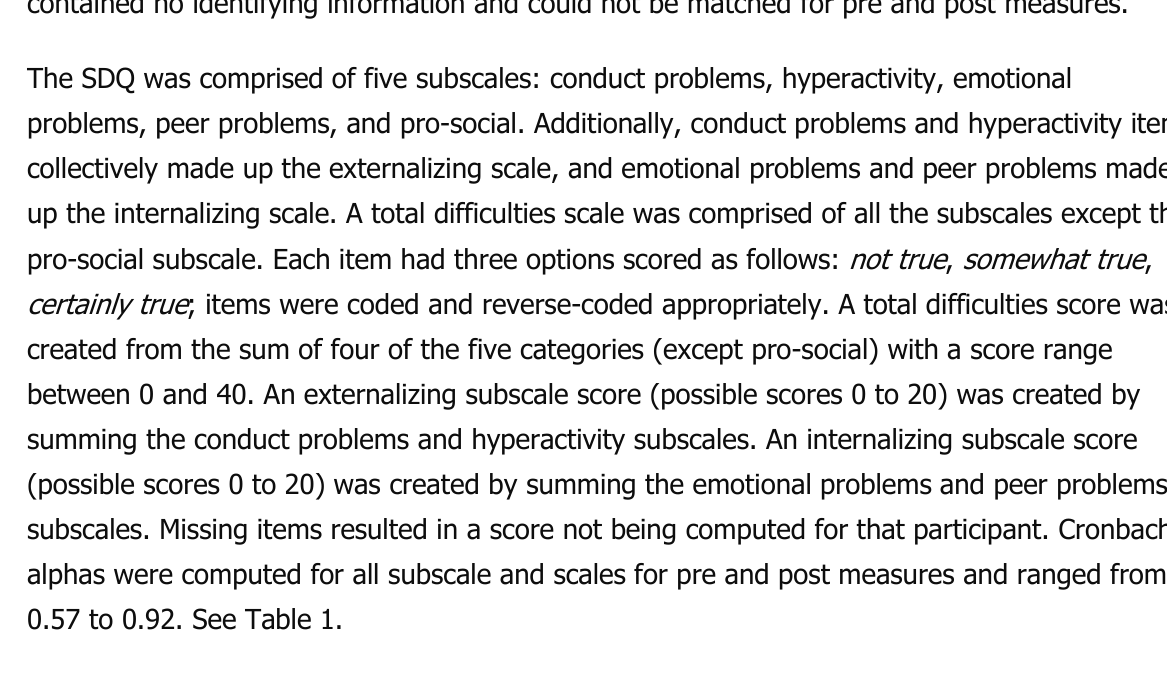
Table 1. Cronbach Alphas for SDQ Subscales and Scales at Pre and Post